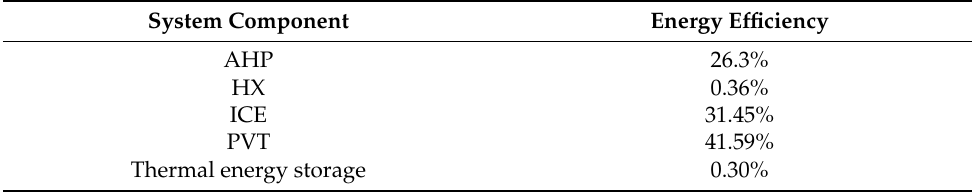
Table 2. The exergy destruction caused by each system component